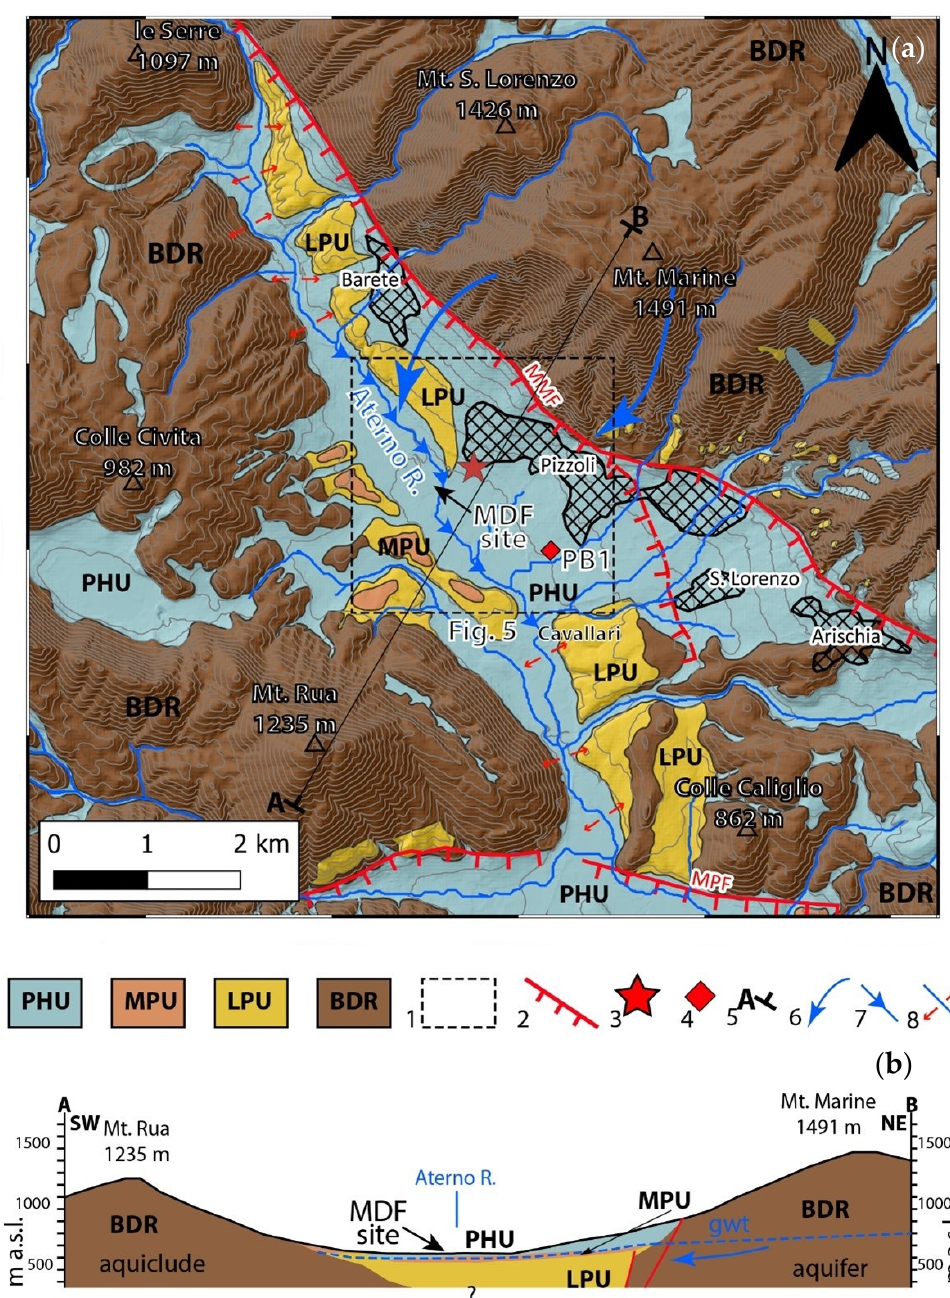
Figure 4. ( a ). Geological and hydrogeological map of the UAV modified after [52,56,60]. Legend: PHU = Late Pleistocene and Holocene deposits, MPU = Middle Pleistocene deposits, LPU = Lower Pleistocene deposits, BDR = Meso-Cenozoic bedrock, 1: box of Figure 5, 2: normal fault, 3: epicentral area of 2 February 1703, earthquake, 4: PB1 borehole, 5: section trace, 6: main underground hydrological flow direction, 7: inflow of Aterno R., 8: outflow of Aterno R. In the lower box ( b ), geological section crossing the UAV and reporting the hydrogeological setting modified from [60].